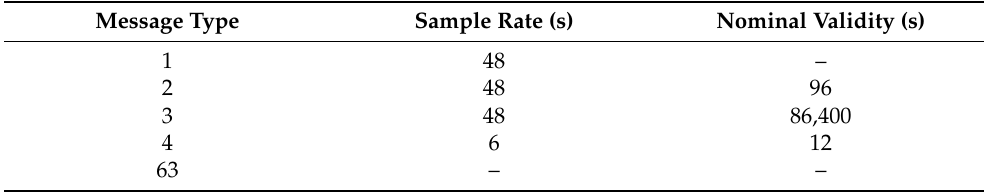
Table 2. The PPP-B2b message